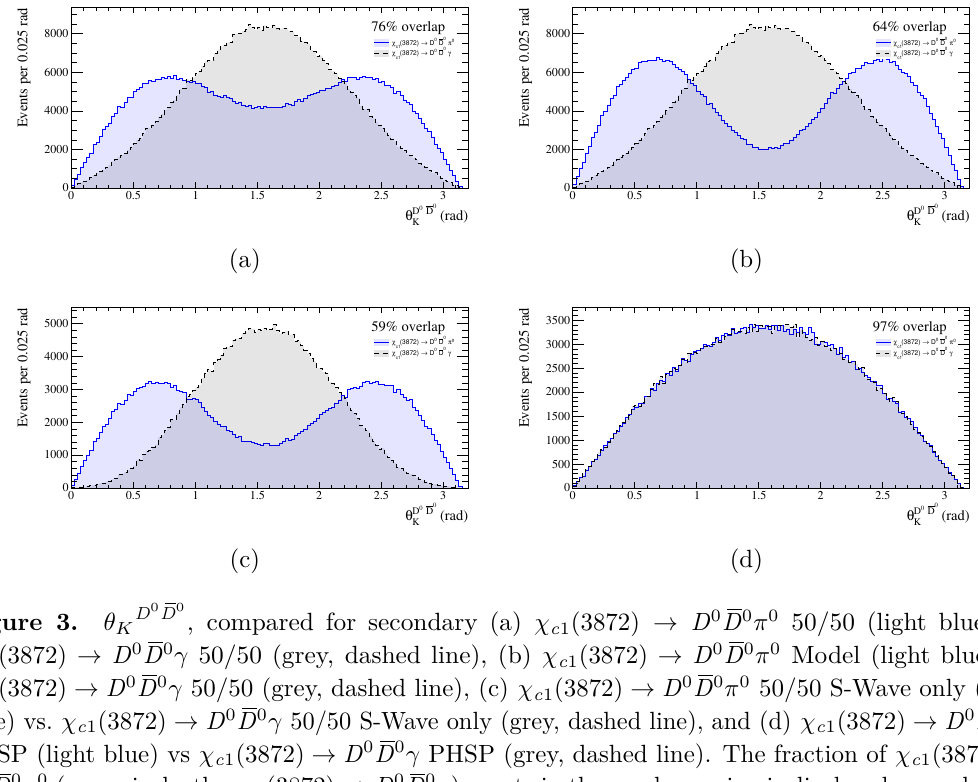
Figure 3. θ K D 0 D 0 , compared for secondary (a) χ c 1 (3872) → D 0 D 0 π 0 50/50 (light blue) vs. χ c 1 (3872) → D 0 D 0 γ 50/50 (grey, dashed line), (b) χ c 1 (3872) → D 0 D 0 π 0 Model (light blue) vs. χ c 1 (3872) → D 0 D 0 γ 50/50 (grey, dashed line), (c) χ c 1 (3872) → D 0 D 0 π 0 50/50 S-Wave only (light blue) vs. χ c 1 (3872) → D 0 D 0 γ 50/50 S-Wave only (grey, dashed line), and (d) χ c 1 (3872) → D 0 D 0 π 0 PHSP (light blue) vs χ c 1 (3872) → D 0 D 0 γ PHSP (grey, dashed line). The fraction of χ c 1 (3872) → D 0 D 0 π 0 (or equivalently χ c 1 (3872) → D 0 D 0 γ ) events in the overlap region is displayed on each